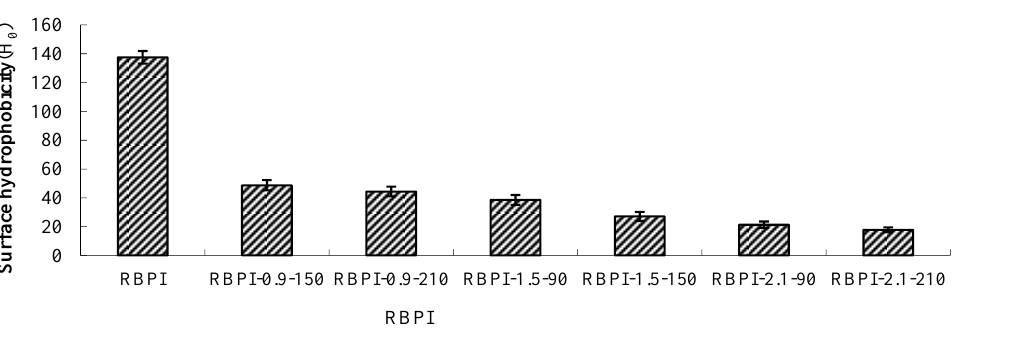
Figure 1. Surface hydrophobicity of RBPI prepared from different SFE pretreatment conditions. As can be seen from Figure 1, the surface hydrophobicity of RBPI decreased signifi- cantly ( p < 0.05) after SFE treatment, and the maximum decrease was 87.3%, from 137.5 (RBPI) to 17.5 (rbPI-2.1-210), and the surface hydrophobicity of protein isolates was greatly results of Zhang Yanpeng et al. [14]. The decrease in surface hydrophobicity